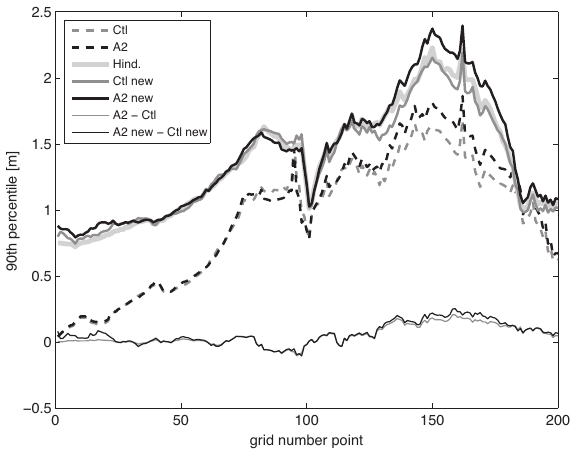
Fig. 5. 90-percentiles for hindcast and scenario storm surge event sets. Original and calibrated (new) event sets are considered. For grid point location see Fig. 1.